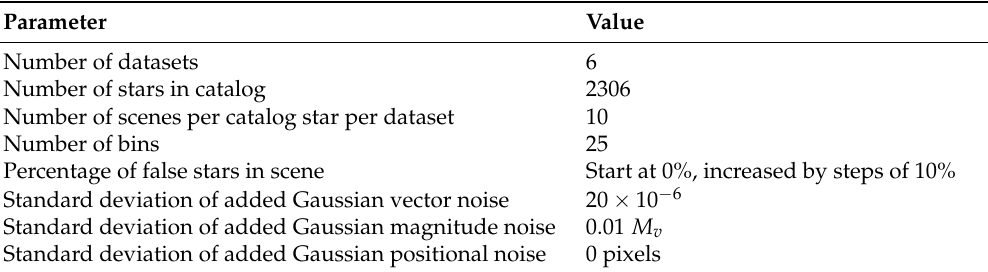
Table 2. False star test dataset